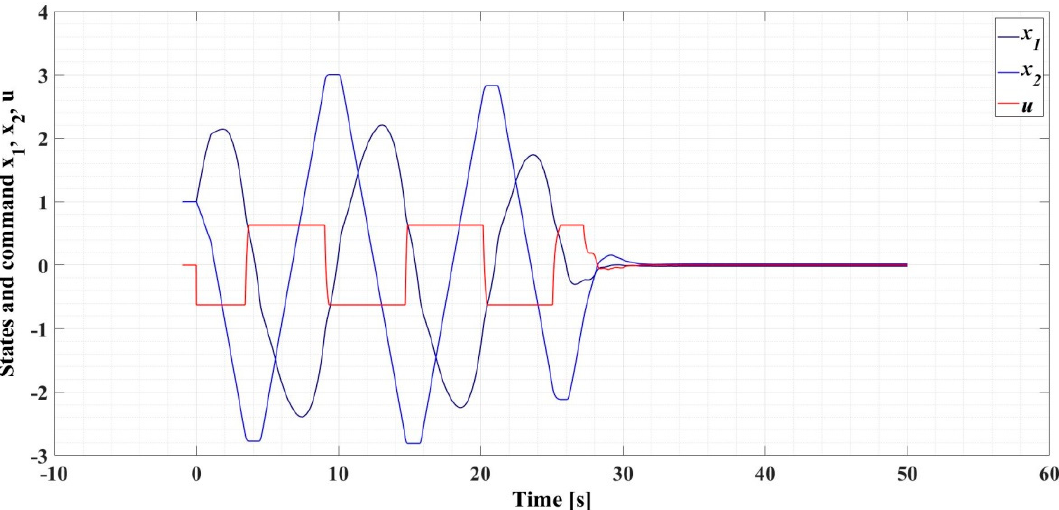
Figure 5. Evolution of the states with | u | ≤ 0.5.